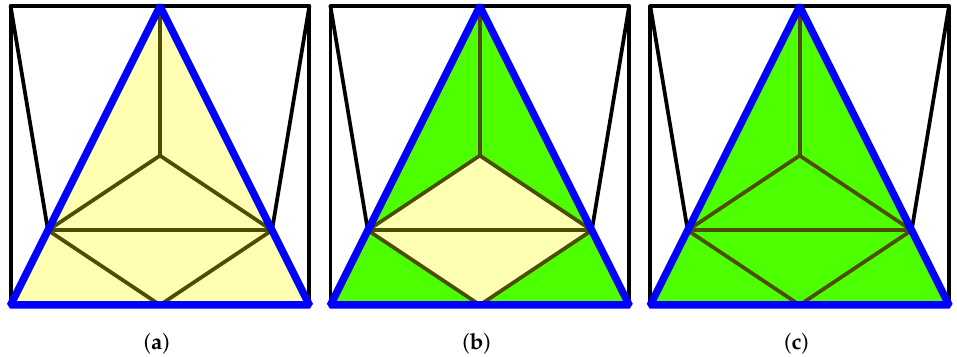
Figure 9. Assignment of facets to a feature. ( a ) Feature boundary detection. ( b ) Adjacent facets of the boundary edges. ( c ) Completed